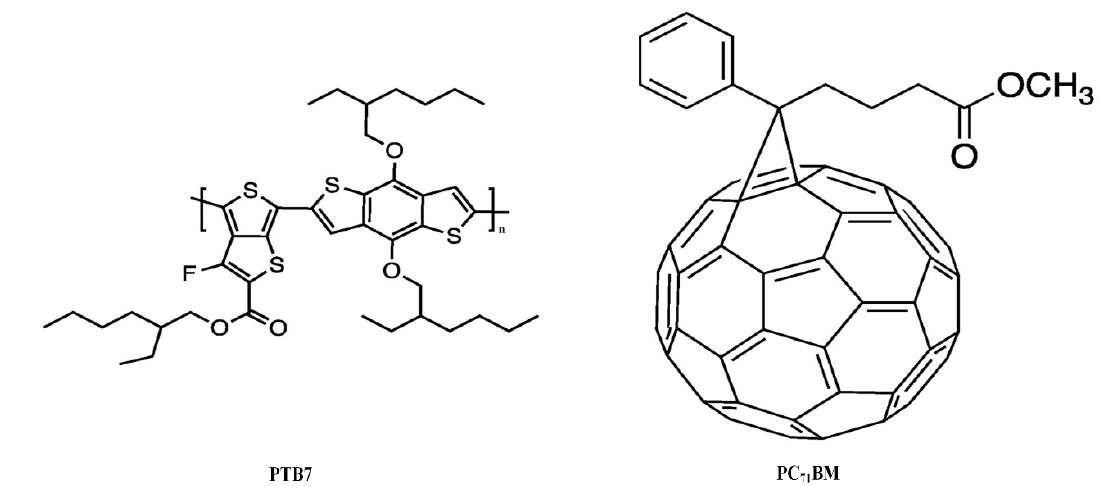
Figure 1. Structures of the active layer of BHJ PSCs consists of PTB7 and PC 71